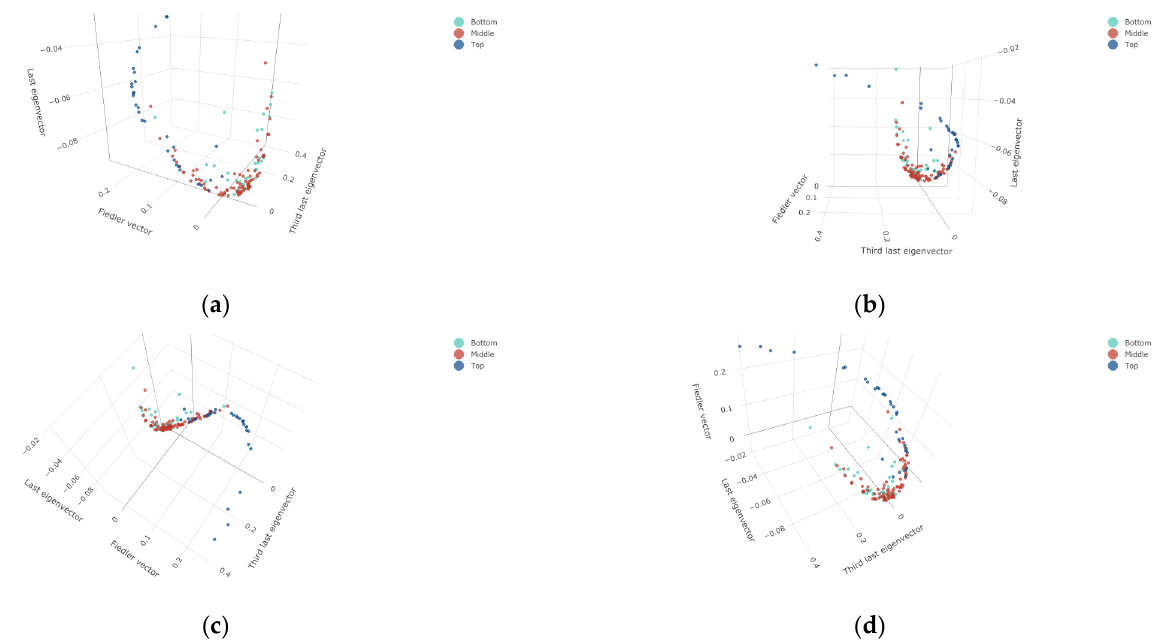
Figure 3. 3D scatter plot of Laplacian eigenmap using the three smallest positive eigenvectors ( a – d ) offer different angles of the 3D structure.